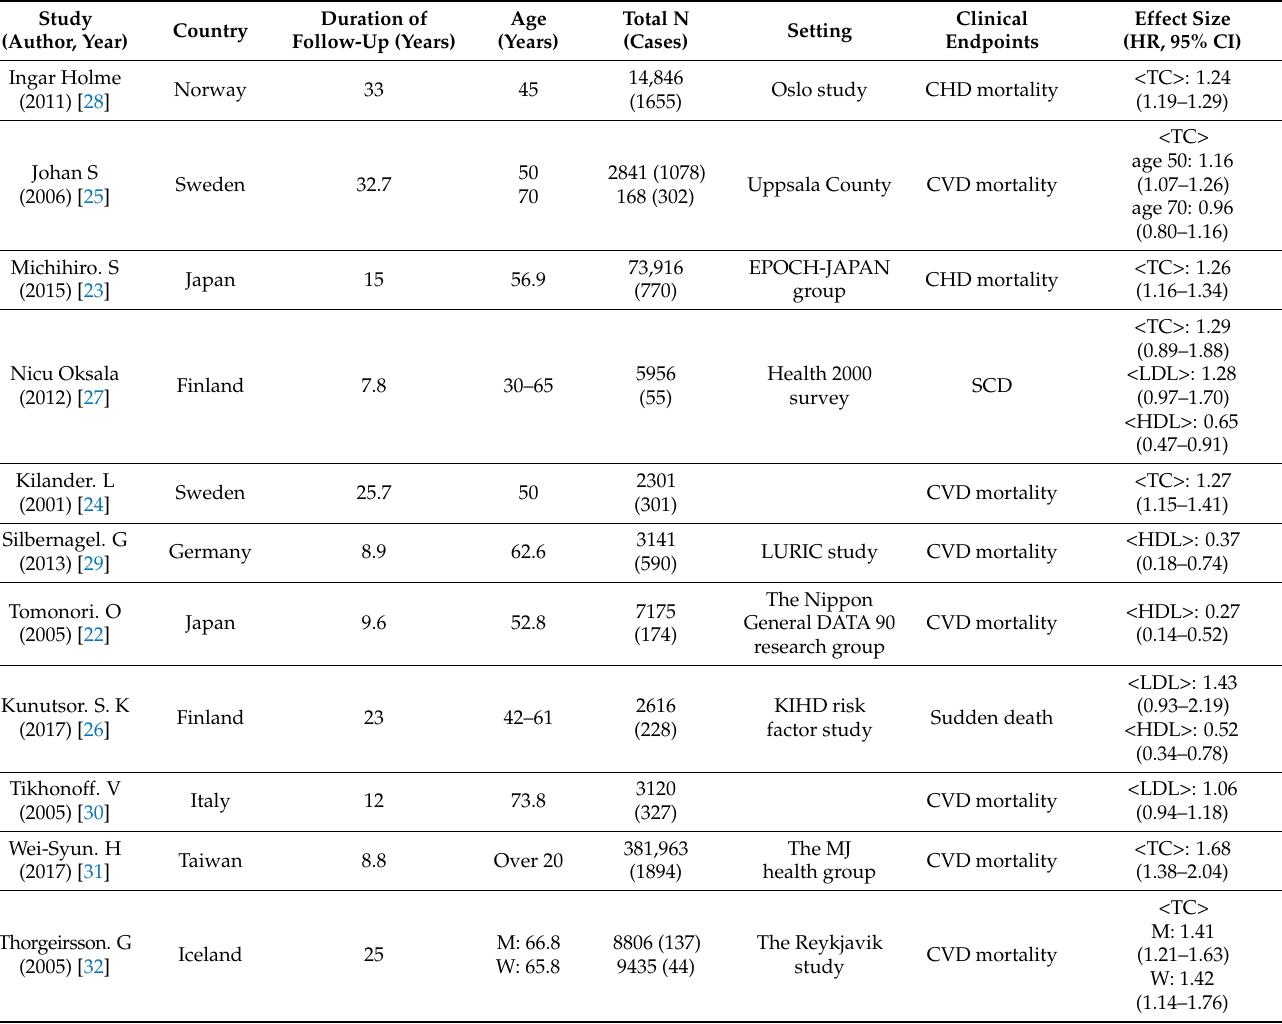
Table 1. Characteristics of included cohort studies of serum cholesterol level and CVD